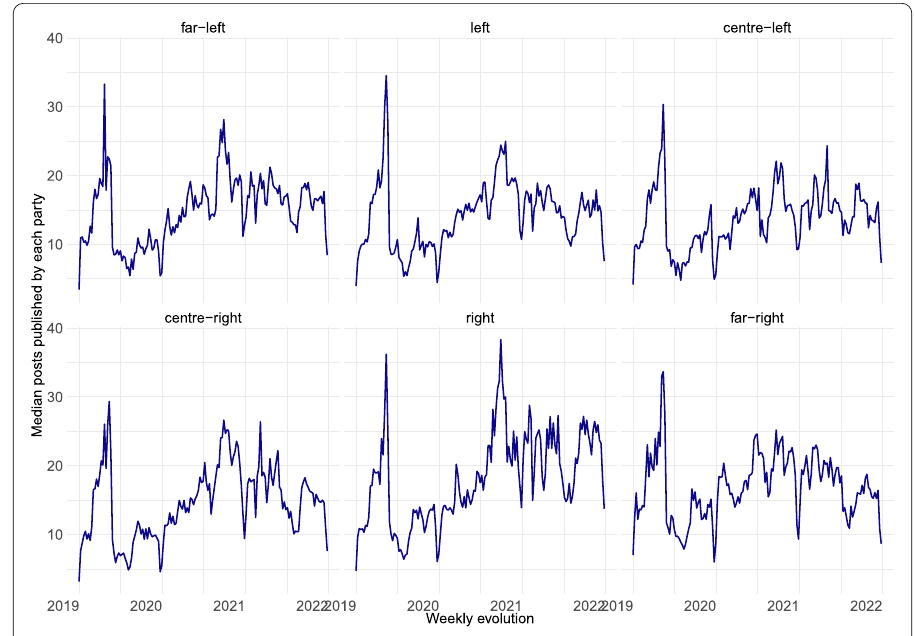
Figure 16 Median number of posts published by different ideology